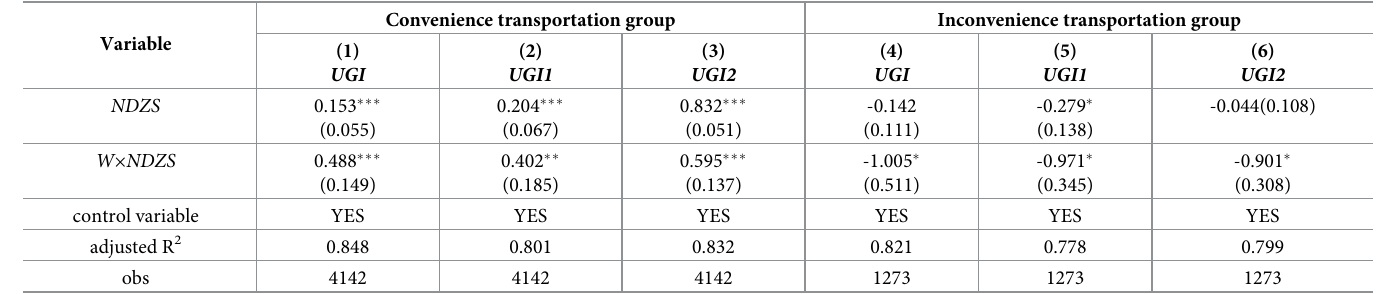
Table 5. Heterogeneity test: Convenience vs. inconvenience transportation.